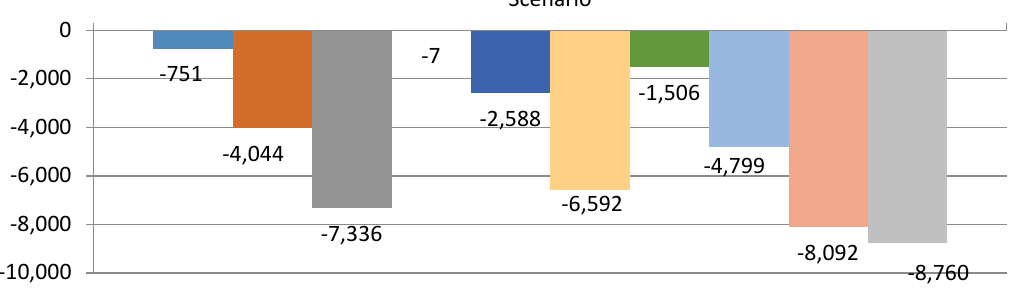
Figure 5. Net present value (NPV) for each scenario if the forecasting period equals five years (tPLN).